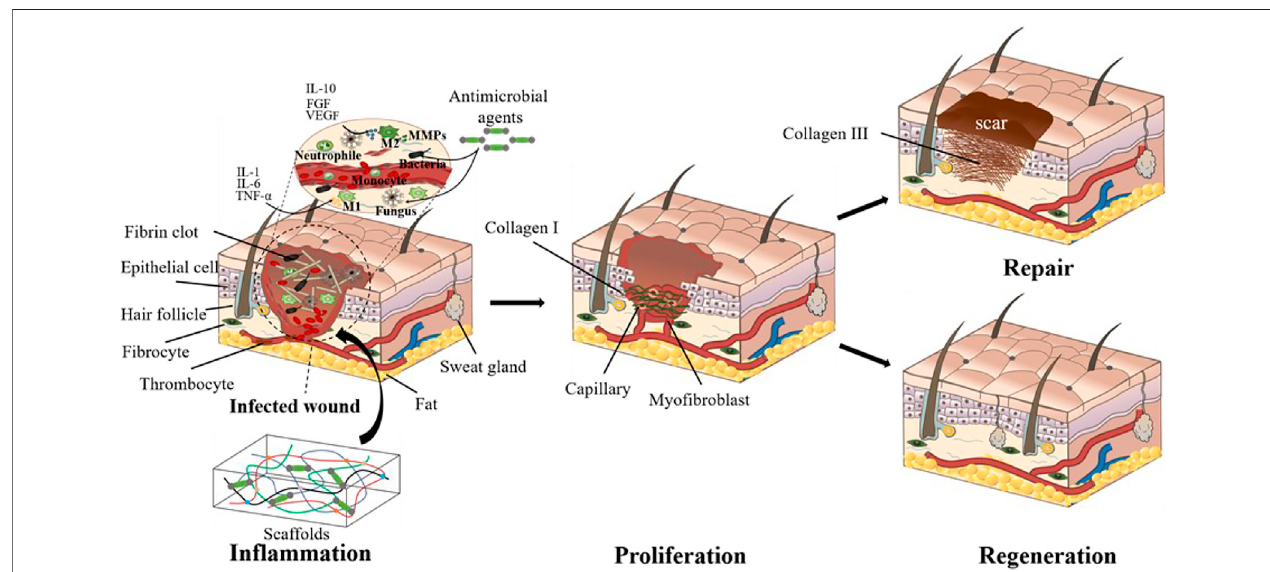
FIGURE 1 | Cutaneous wound healing treated with tissue-engineered scaffolds. The wounds are currently treated either with typical biological scaffolds or pro- regenerative ones. Though both scaffolds facilitate wound healing, the pro-regenerative scaffolds bring about more complete skin structures, while the traditional biological scaffolds mostly lead to scarred